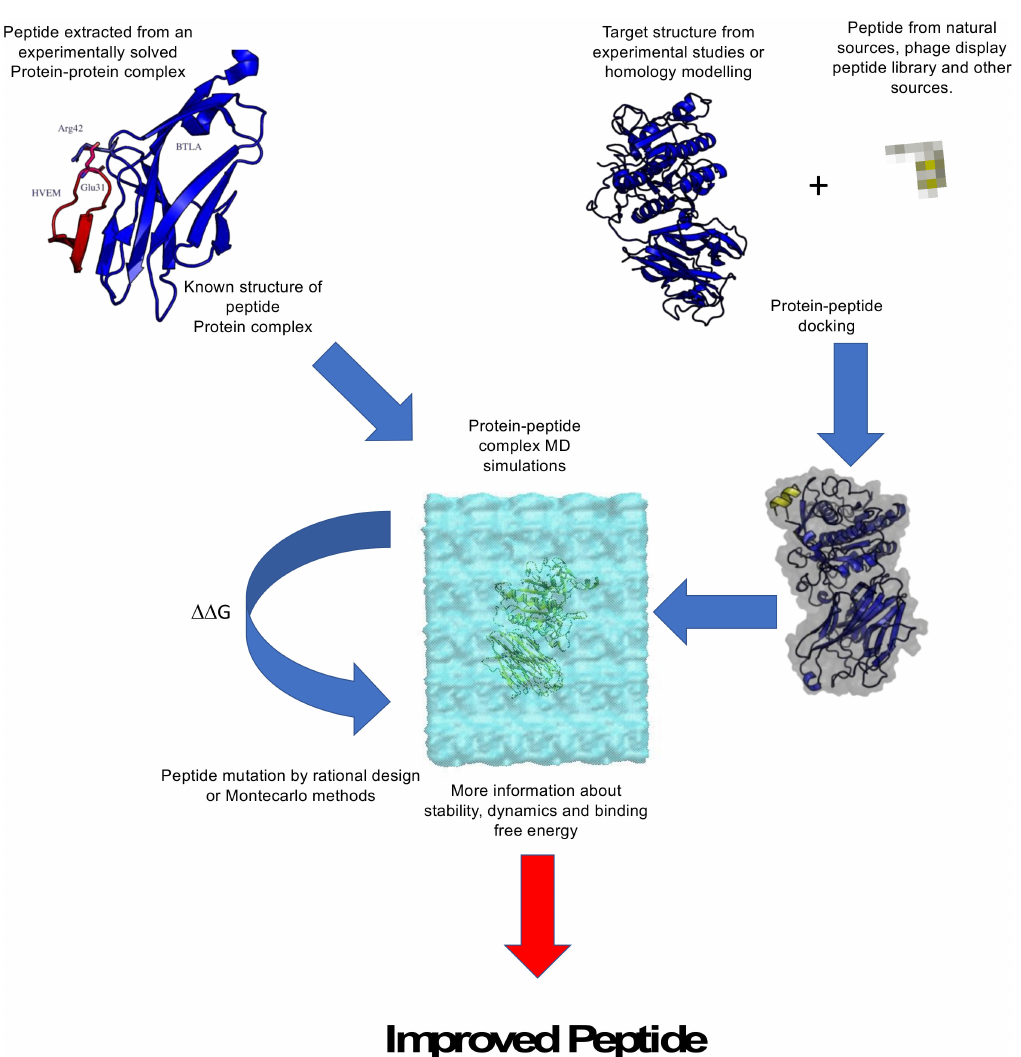
Figure 1. Schematic representation of a computational pipeline for peptide